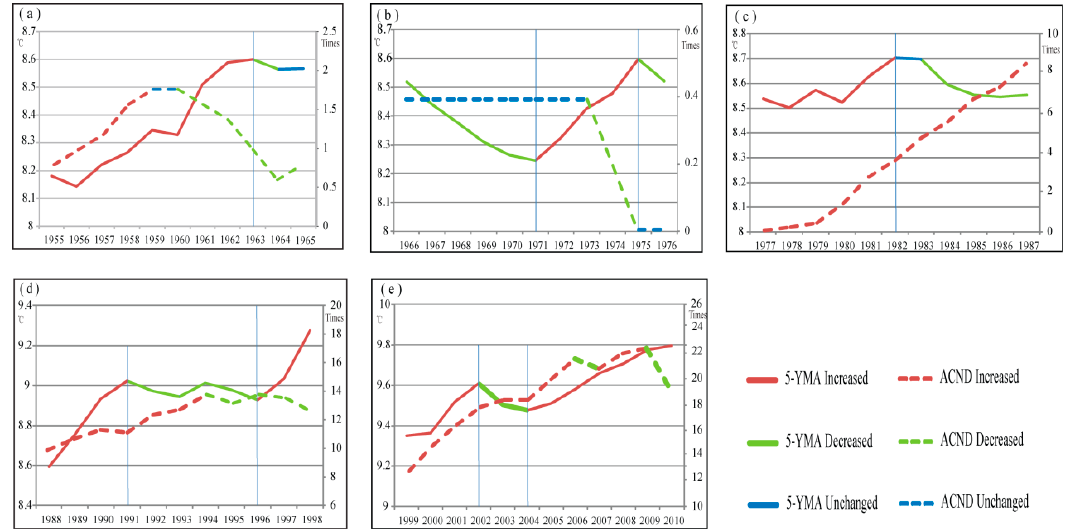
Figure 4. A comparison between the 5-YMAT and ACND in each cycle period in the temperature time series. ( a ) 1955–1965,